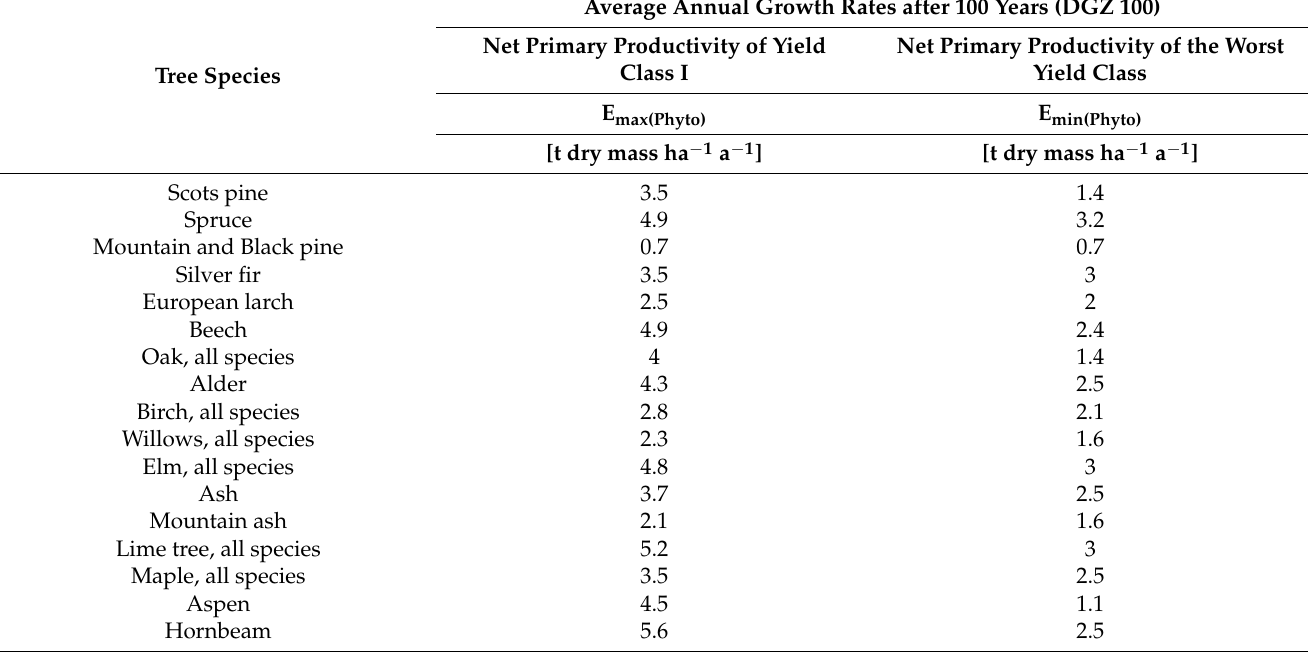
Table 4. Ranges of potential net primary productivity (wood and bark) of dominant and sub-dominant tree species